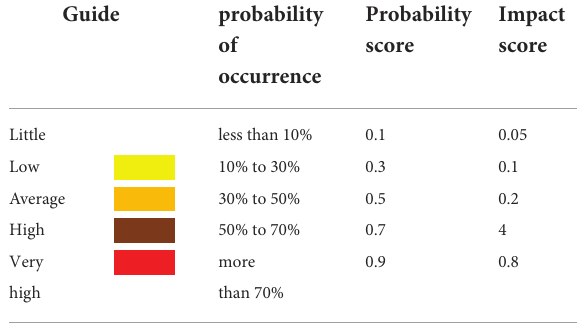
TABLE 3 Risk prioritization matrix